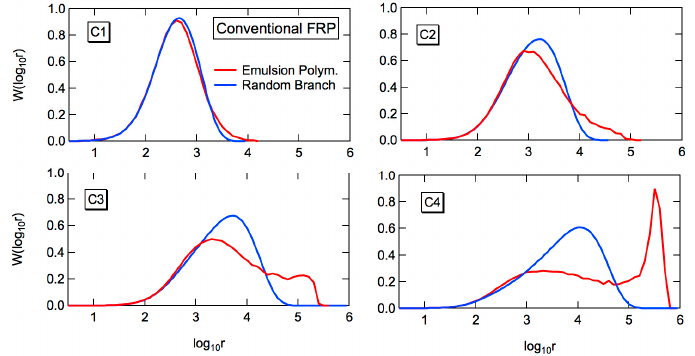
Figure 3. Comparison of the full weight fraction distribution profiles of polymers formed through the conventional emulsion polymerization for the conditions, C1–C4 (red) and the corresponding random branching (blue).